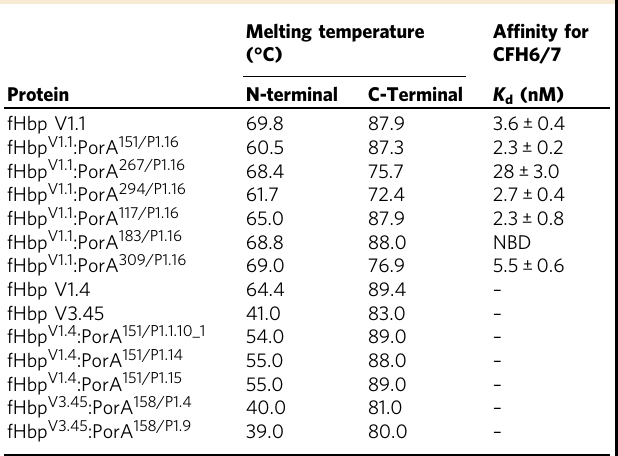
Table 1 ChA stability and af fi nity for CFH 6/7